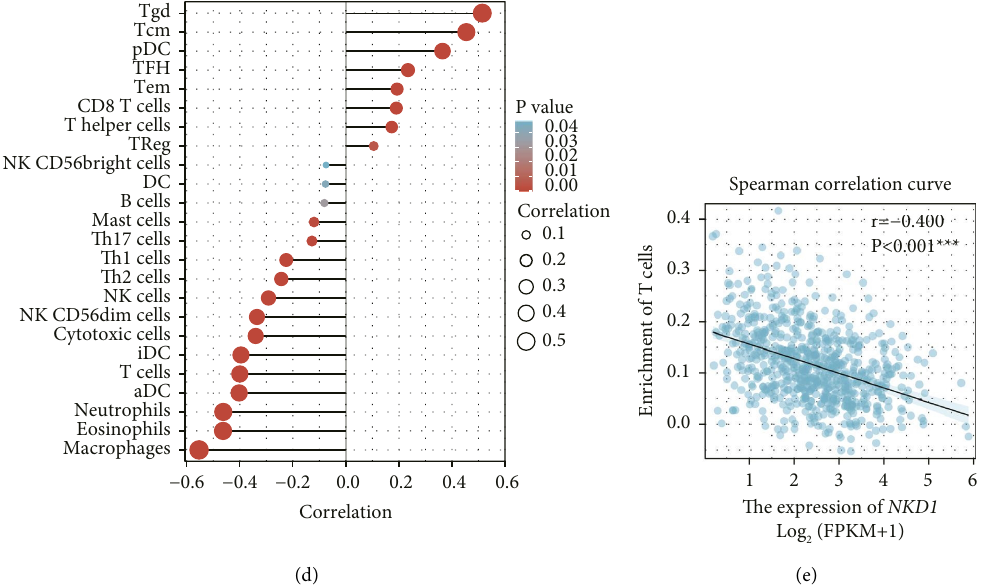
Figure 4: NKD1 is correlated with immune cell enrichment and inhibits GBM growth. (a) RT-qPCR method was used to validate transfection efciencies of pcDNA3-NKD1 and pcDNA3-vector plasmids. Te blank group referred to cells treated with only transfection reagent without any plasmid. (b) Colony formation assay was conducted to evaluate GBM cell proliferation capacity. (c) Te MTTmethod was used to dynamically monitor the growth curves of transfected GBM cells. (d) Te correlations between immune cell enrichment and NKD1-mRNA level in GBM tissues were summarized. (e) Spearman correlation test indicated a negative correlation between NKD1-mRNA level and T cell infltration in